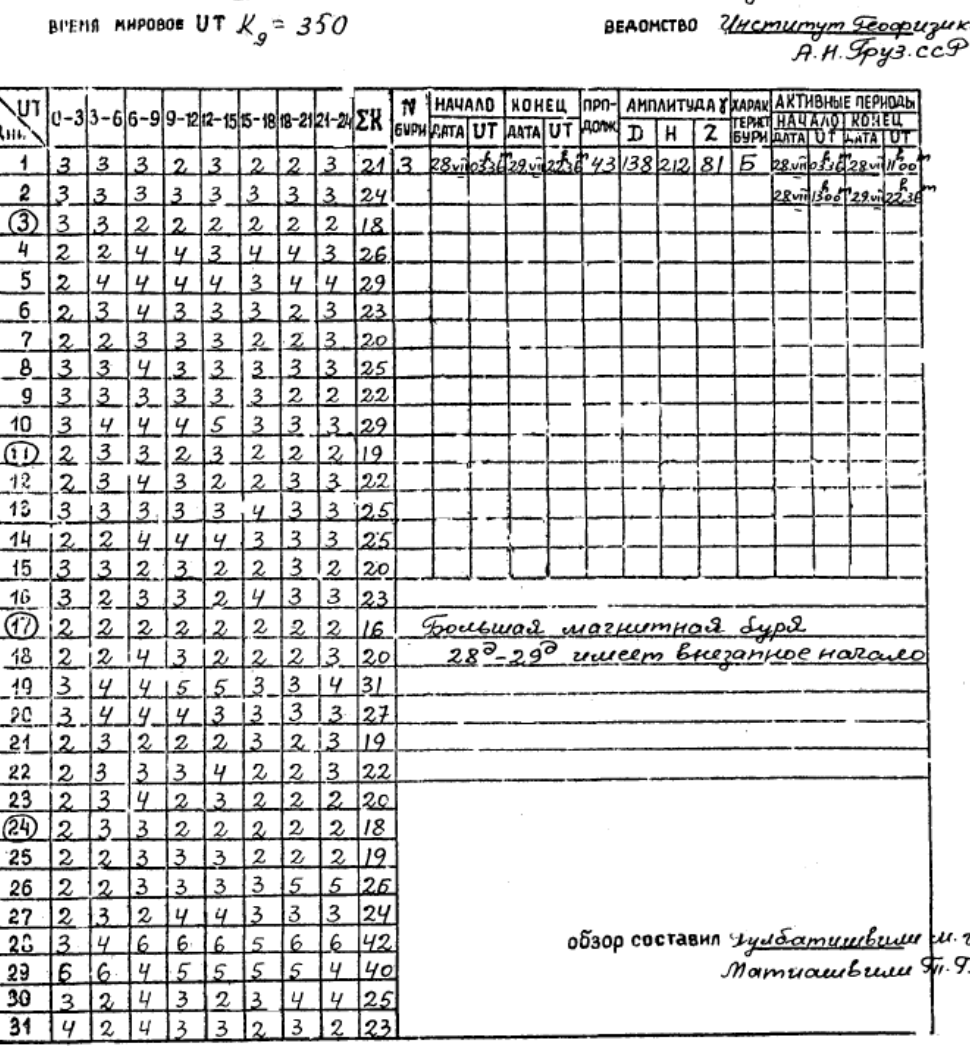
Figure 6. Monthly K index values data sheet for observatory Tbilisi (TFS), Georgia (July 1990), compiled according to the form proposed by IZMIRAN (http://www.wdcb.ru/stp/data/K_indices/TFS_Tbilisi/TFS_1990_1-7+st.pdf, last access: 15 February